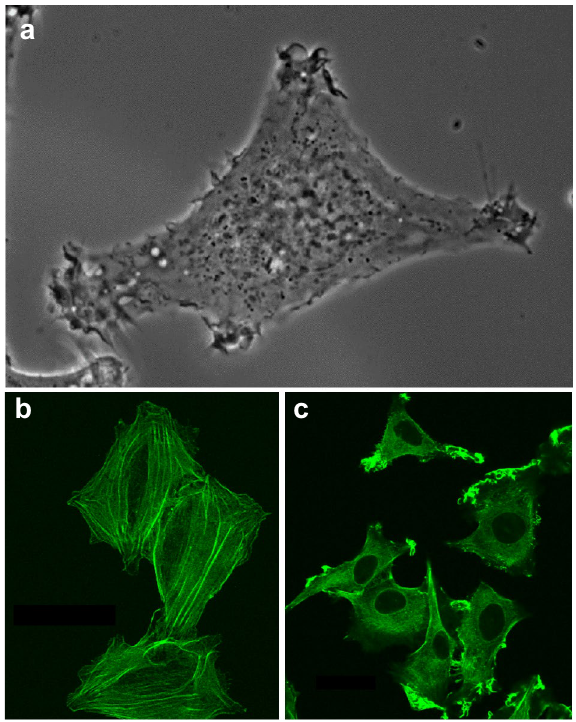
Figure 1. ( a ) One frame from a movie of a sarcoma cell from the metastatic population T15 acquired using LSM 510 (Zeiss) equipped with Plan-Apochromat 63 × /1.4 Oil Ph3. The field size is 93 × 63 µm. ( b , c ) Micrographs of fixed sarcoma cells stained with rhodamine-phalloidin acquired as stacks using LSM 510 (Zeiss) are presented as maximum intensity projection with green pseudo-color. ( b ) K2 cells from the non- metastatic line feature conspicuous stress fibers. The field size is 154 × 184 µm. ( c ) A297 cells from the highly metastatic line, which have lost the stress fibers. The field size is 140 × 159